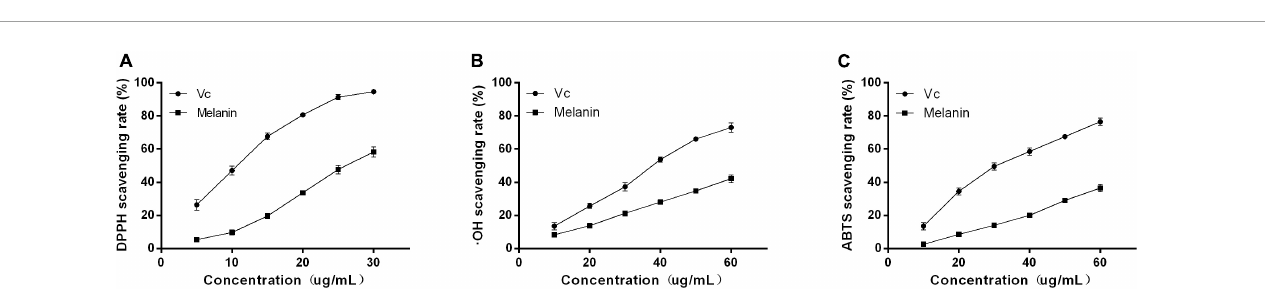
FIGURE6 The antioxidant activities of A. heimuer melanin (AHM). The scavenging rate of both AHM and Vc against DPPH (A) , OH (B) , and ABTS (C) free radicals are shown.